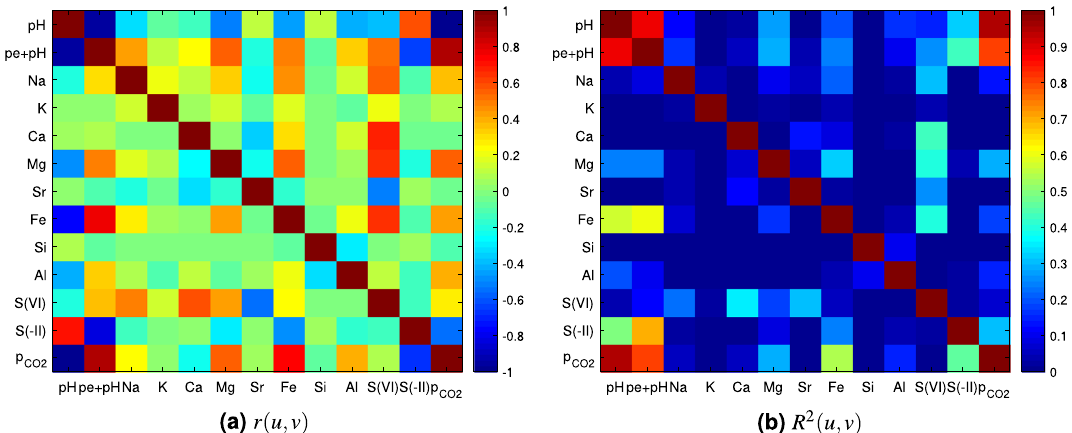
Figure 3. Matrices of correlation coefficient r ( u , v ) and coefficient of determination R 2 ( u , v ) for the small range case (lower part of matrices) and the large range case (upper part of matrices) estimated with 10 6 realizations of the surrogate